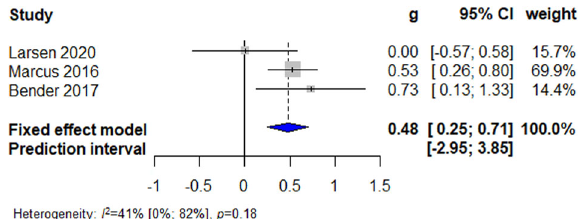
Fig. 6 Fixed effects meta-analysis of culturally adapted IMI for physical activity vs. active control conditions. Forest plot present- ing fi xed effects meta-analysis of culturally adapted IMI for physical activity vs. active